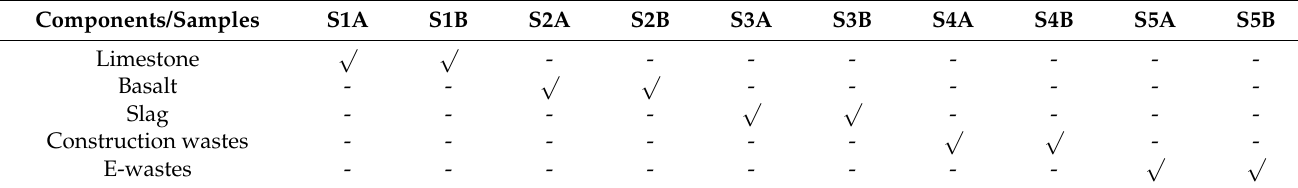
Table 1. Aggregate components of the produced concrete